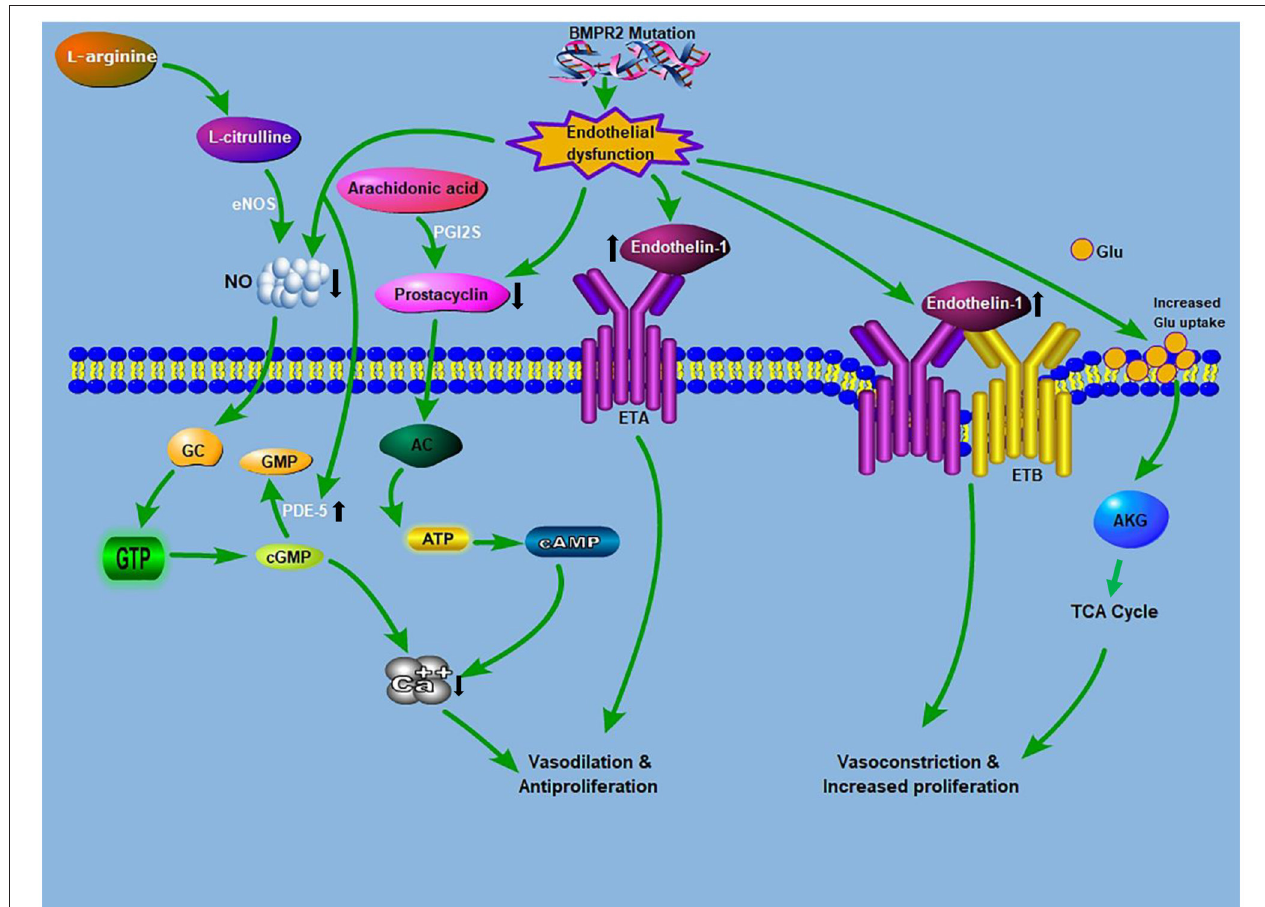
FIGURE 1 | Crosstalk between glutaminolysis and the known PAH pathogenesis: The known PAH pathogenesis: NO, produced from L -arginine, stimulates cGMP production. cGMP causes relaxation and inhibition of vascular SMCs proliferation. PDE5 inhibitors augment the vasodilatory mechanism through the prevention of cGMP deterioration. Prostacyclin from ECs promotes relaxation and inhibition of cell proliferation via a cAMP-dependent mechanism. Endothelin is an effective vasoconstrictor that induces proliferation via ET A receptors on SMCs, while stimulating NO and prostacyclin discharge via endothelial ET B receptors. Glutamate provides carbon intermediates ( α KG) for the TCA cycle, thereby promoting cellular ATP production, which culminates in increase proliferation and development of antiapoptotic phenotypes. BMPR2 mutation drives endothelial dysfunction, which causes increased endtholin-1 levels and increases glutamate uptake in endothelial cells. AC, adenylyl cyclase; ATP, adenosine triphosphate; AKG, α -ketoglutarate; BMPR2, bone morphogenetic protein receptor 2; ETA, endothelin receptor A; ETB, endothelin receptor B; cAMP, cyclic adenosine monophosphate; cGMP, cyclic guanosine monophosphate; eNOS, endothelial nitric oxide synthase; GTP, guanosine triphosphate; GC, guanylyl cyclase; Glu, glutamine; NO, nitric oxide; PDE-5, phosphodiesterase 5; PGI2S, prostacyclin synthase; TCA, tricarboxylic